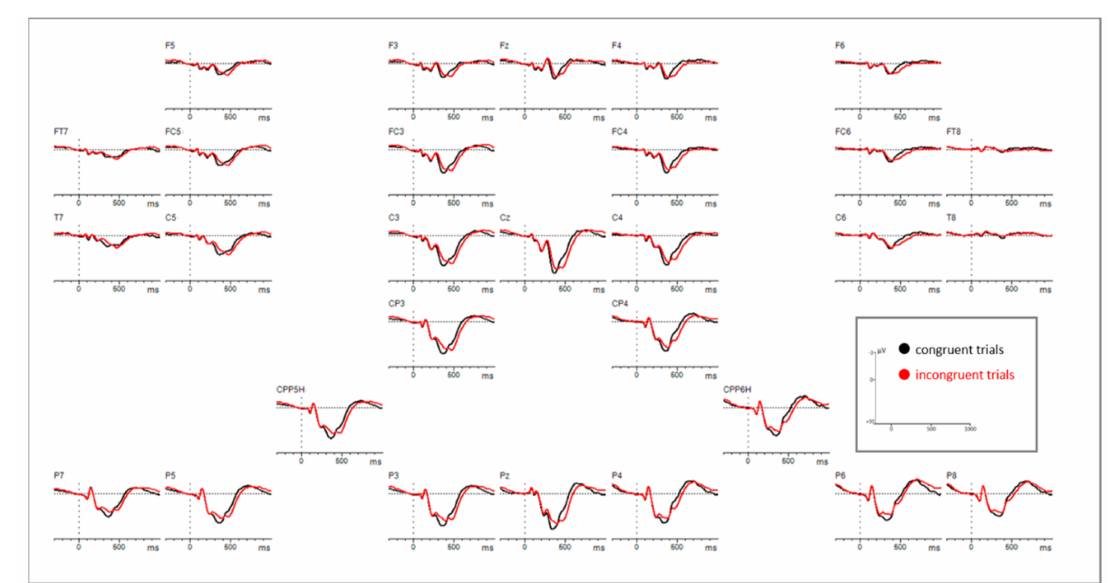
Figure A1. Grid view of controls ( n = 29), showing the processing of congruent versus incongruent stimuli on all channels.